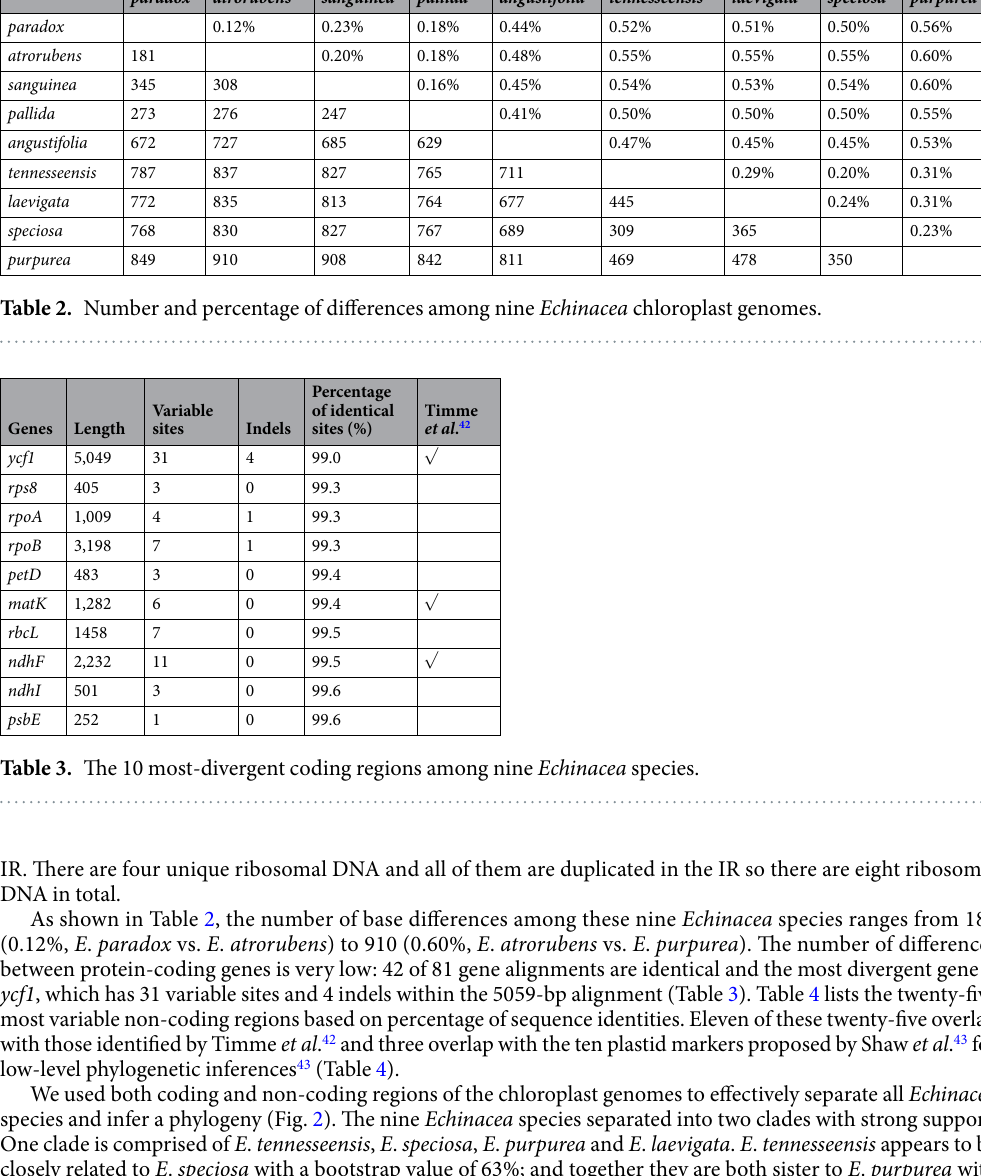
low-level phylogenetic inferences 43 (Table 4).